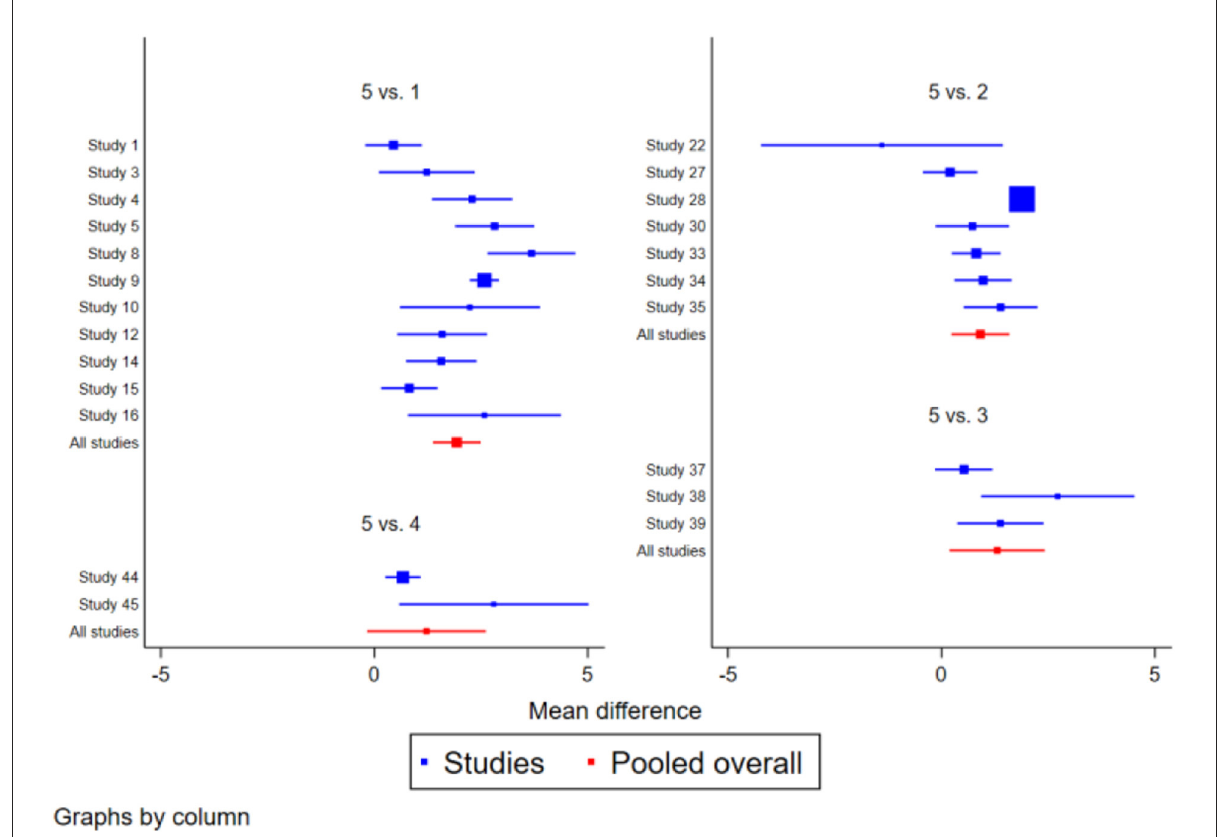
FIGURE3 Forest plot of the effect of traditional Chinese physical exercise therapy on TUGT of the